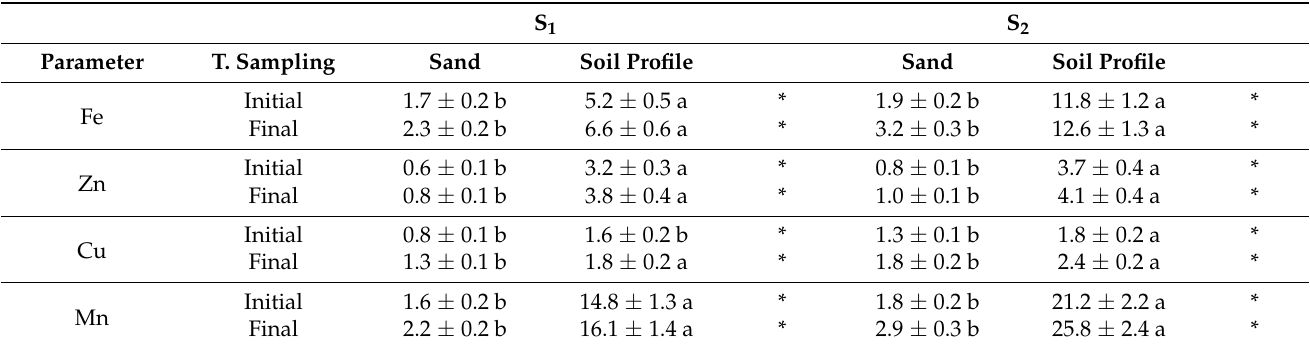
Table 4. Comparison of average concentration of Fe, Zn, Cu, and Mn (mg kg − 1 ) in sand and soil profile at the start and final stage of the crop cycle. S 1 S